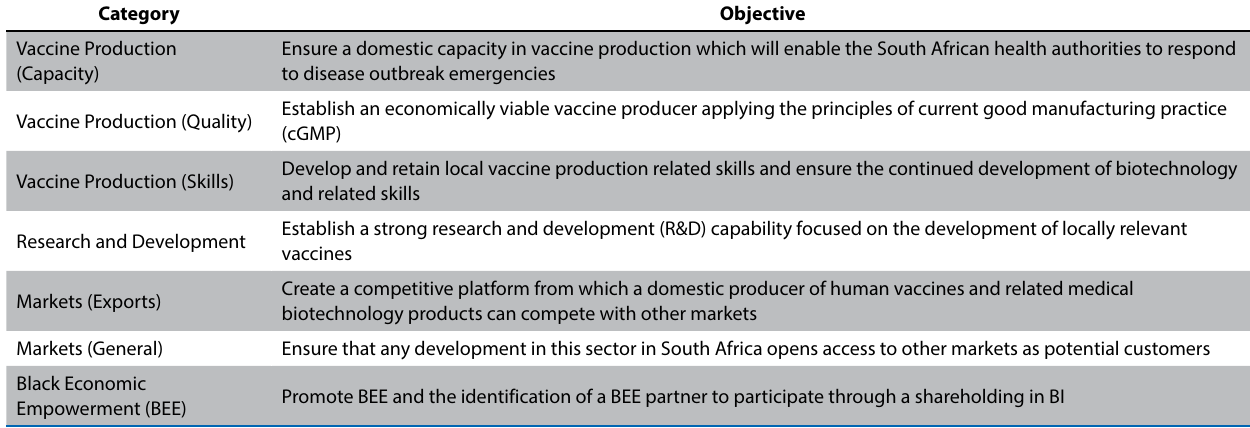
Table 1. BI-PPP objectives as listed in the Shareholders